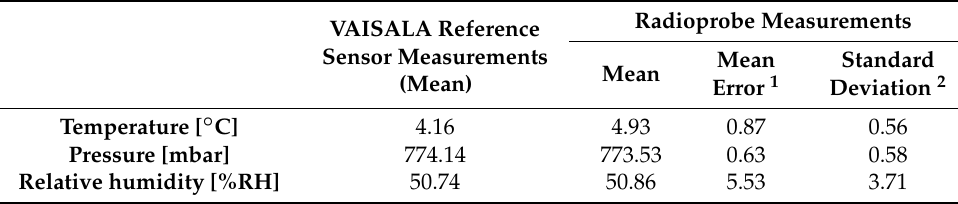
Table 6. Statistical comparison between radioprobe sensor readings and ARPA reference sonde